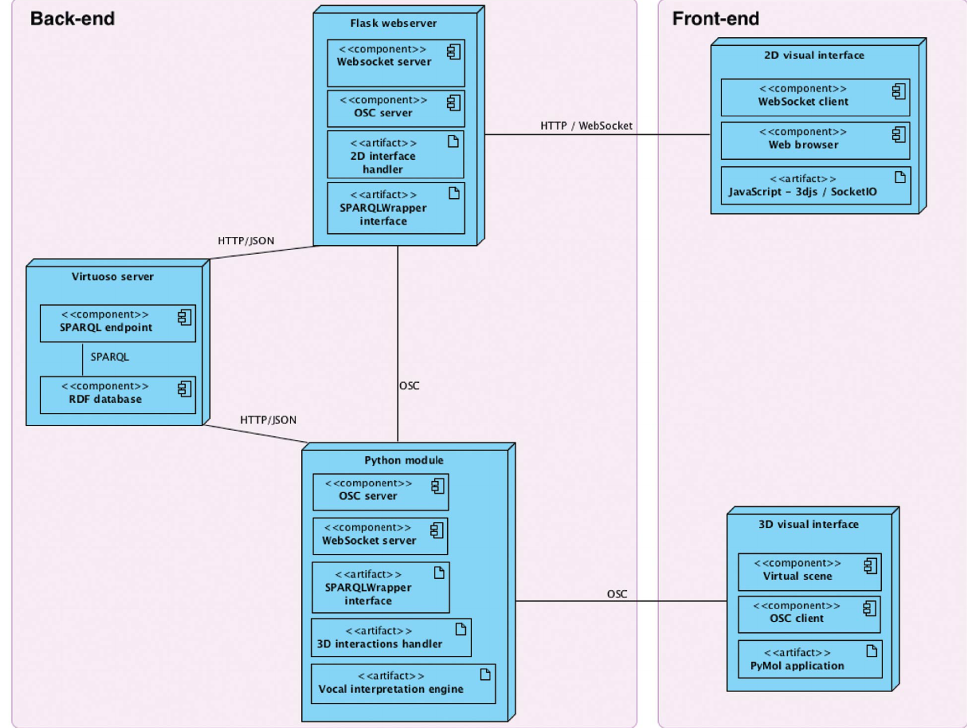
Figure 6: Software and hardware architecture of our platform as UML deployment